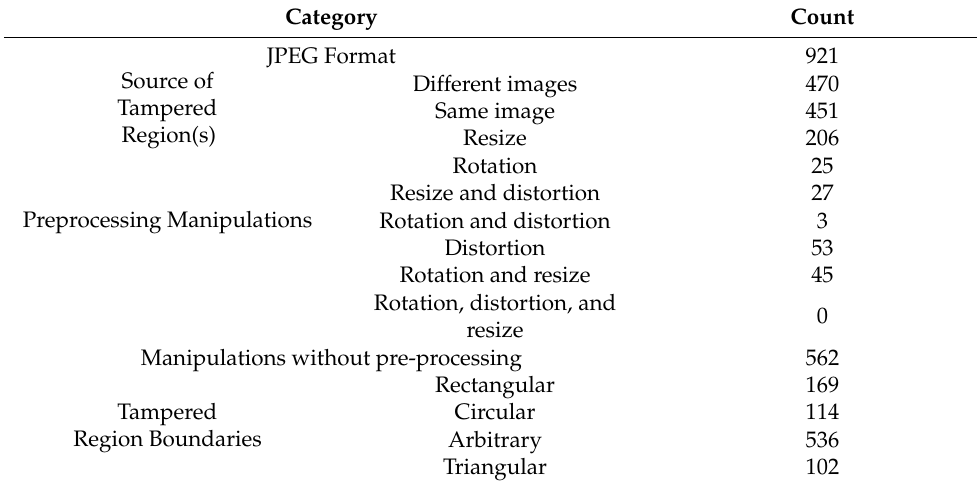
Table 2. Statistical information of spliced